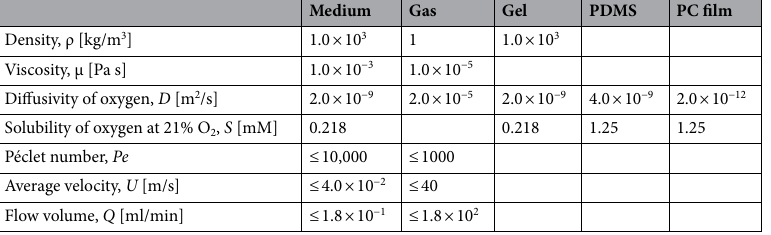
Table 2. Physical properties of each component and parameters.